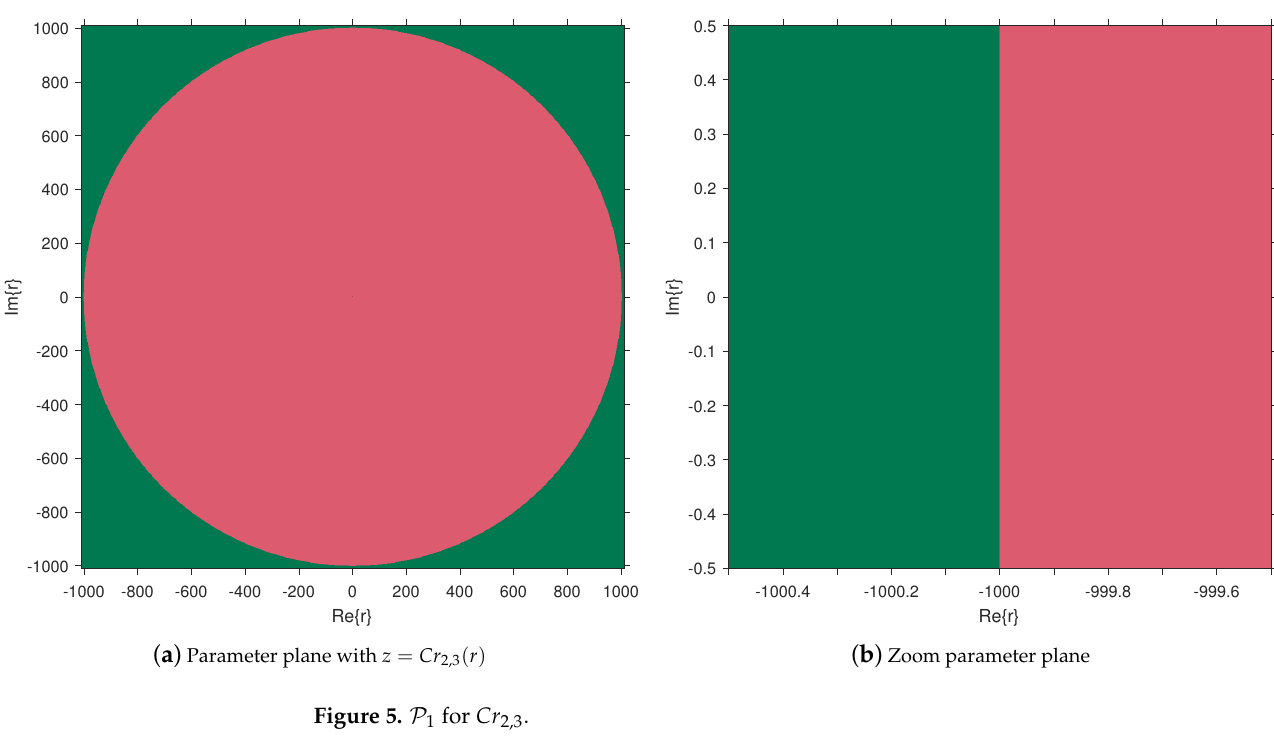
Figure 4. Parameter spaces for free critical points Cr 1 = − 1.